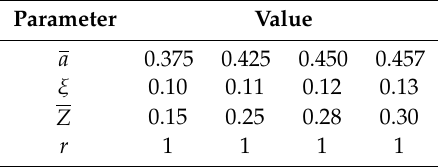
Table 1. Parameters of vibration isolator.